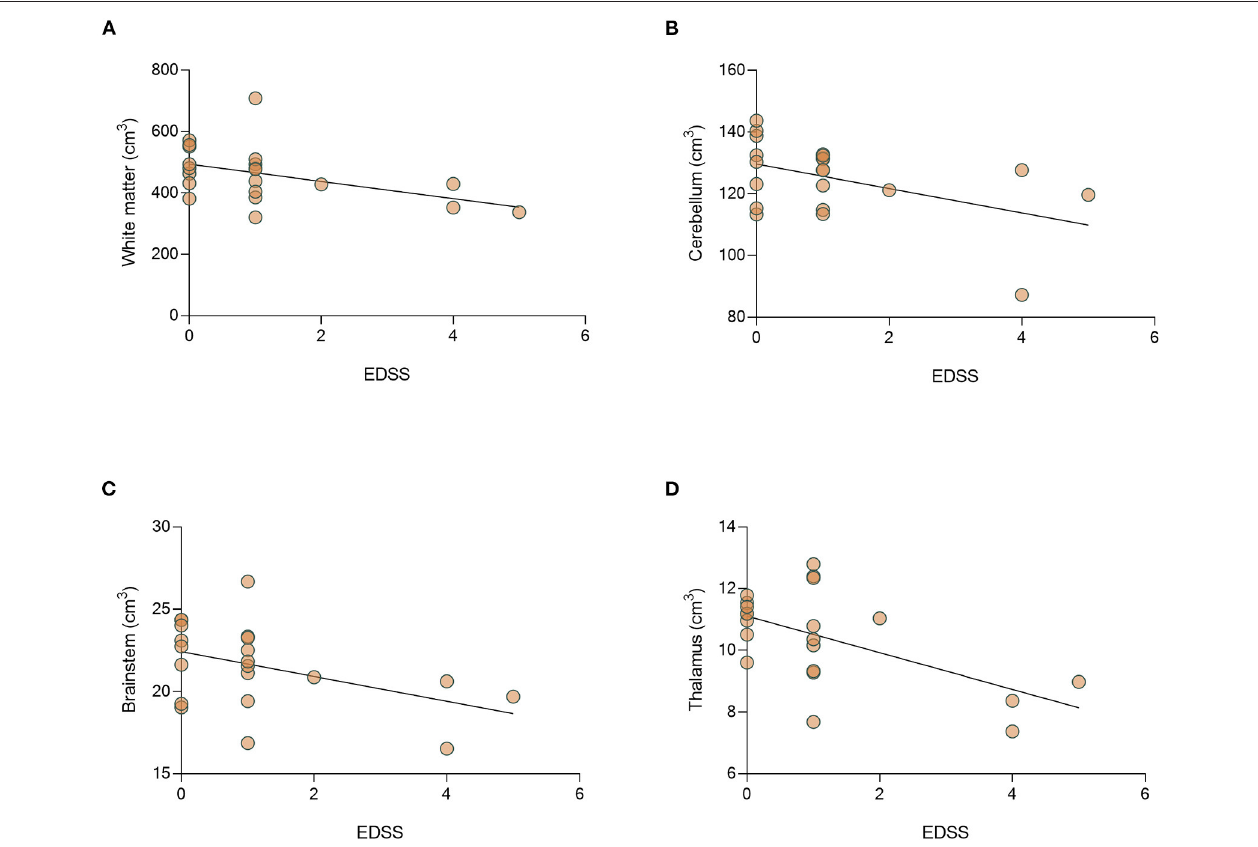
FIGURE 7 | There is a significant correlation between EDSS and decrease volume of thalamus of MOGAD patients. Correlation between EDSS and brain volumes. Correlation between EDSS and volumes of (A) white matter ( r = − 0.051, p = 0.021), (B) cerebellum ( r = − 0.389, p = 0.082), (C) brainstem ( r = − 0.393, p = 0.078), and (D) thalamus ( r = − 0.476, p = 0.029) in MOGAD patients ( n = 22). MOGAD, Myelin oligodendrocyte glycoprotein antibody